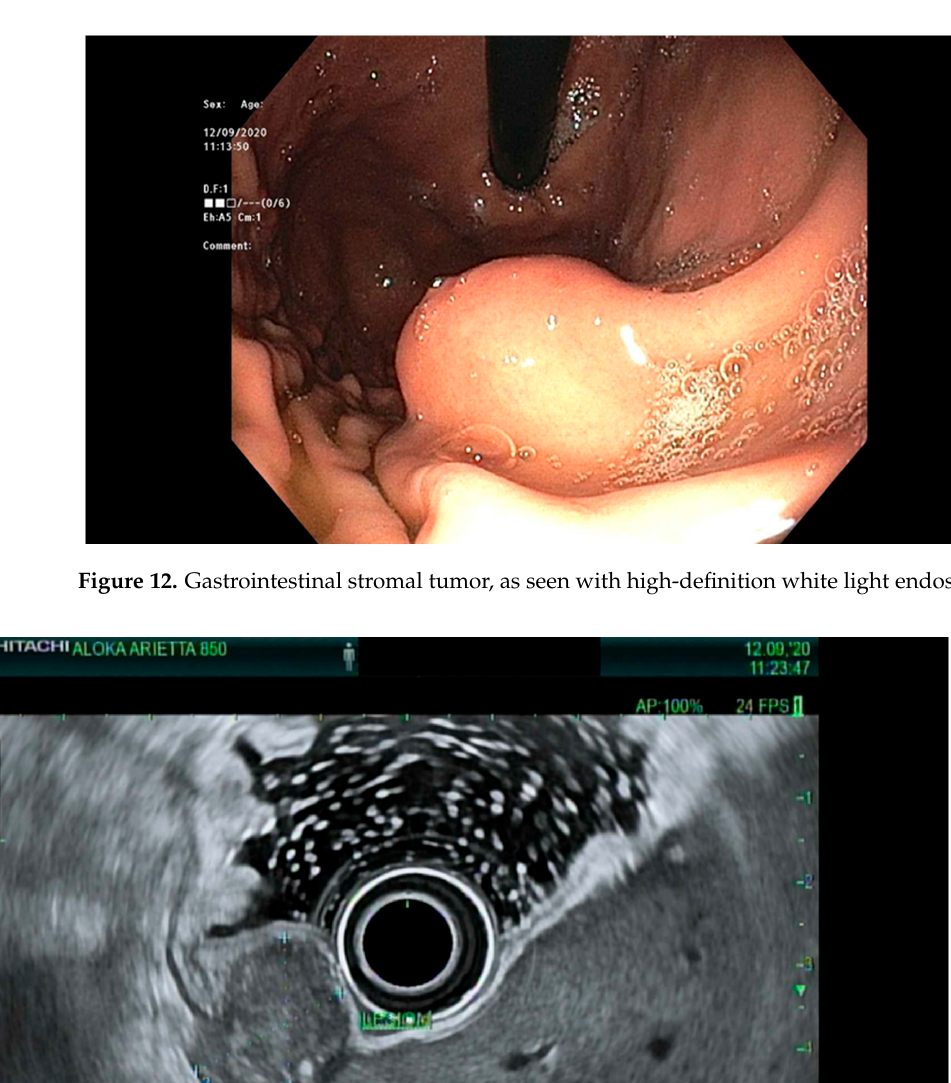
Figure 11. Early gastric cancer; EUS image polypoid lesion T1N0.